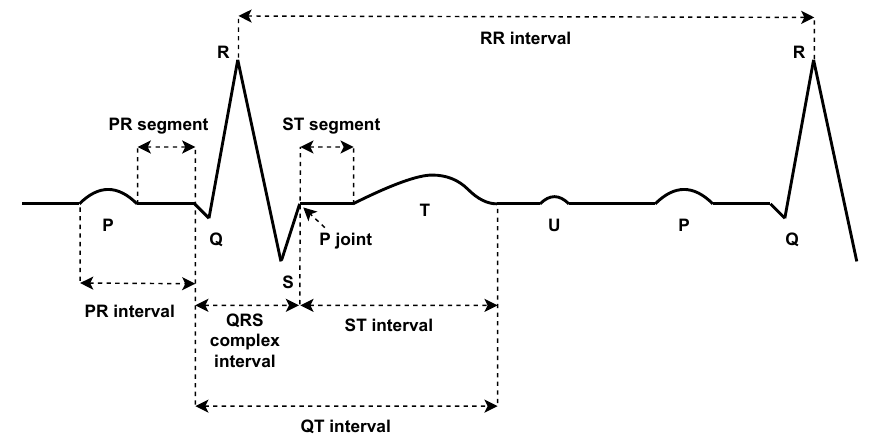
Figure 2. Normal ECG